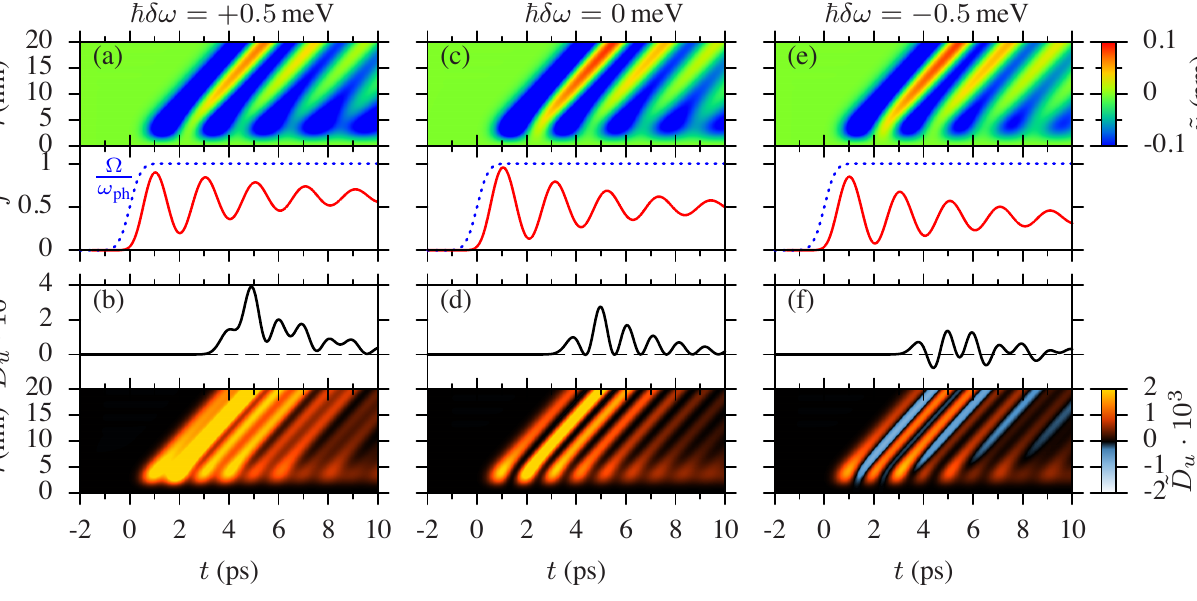
Figure 2. ( a , c , e ) Mean lattice displacement ˜ u ( r, t ) (upper panel); Rabi frequency Ω (dashed blue) and occupation f of the exciton state (solid red) (lower panel); ( b , d , f ) fluctuations ( r, t ) (lower panel), as well as their temporal profiles at r = of the lattice displacement ˜ D u 20 nm (upper panel): (a,b) positive detuning (cid:126) δω = +0 . 5 meV ; (c,d) resonant excitation 0 . 5 meV (cid:126) δω = 0 meV ; (e,f) negative detuning (cid:126) δω = −